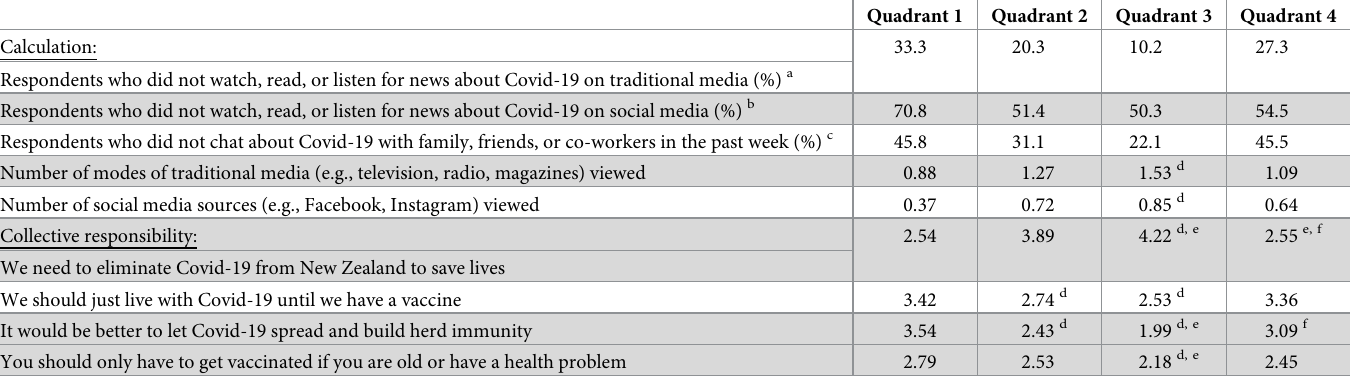
Table 8. I 3 vaccine classification, calculation, and collective